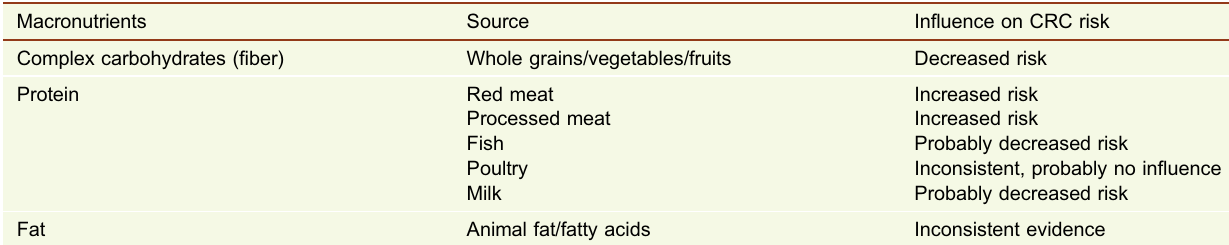
Table 1. Dietary factors that in fl uence CRC risk